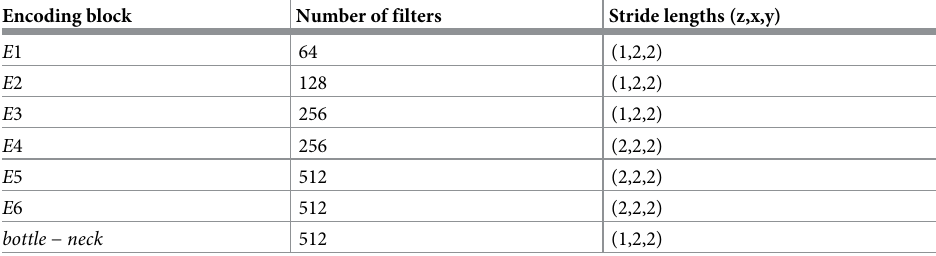
Table 1. The number of filters and stride lengths that were used in the three-dimensional Pix2Pix GAN’s encoding blocks. Encoding